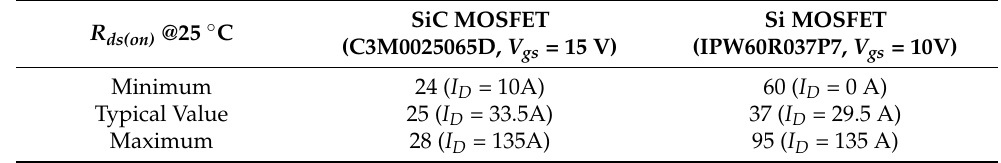
Table 3. The comparison between SiC and Si MOSFETs.